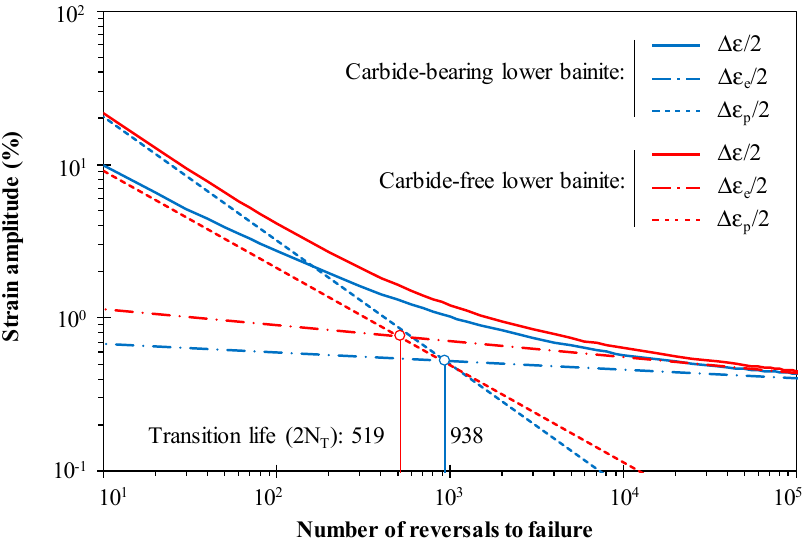
Figure 7. Strain-life relationships accounted for in terms of total strain, elastic strain, and plastic strain components for the carbide-bearing and carbide-free bainitic steels. Table 5. Summary of the fatigue strength and fatigue ductility properties.